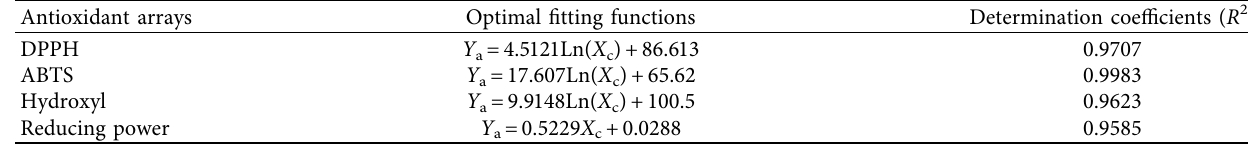
Table 6: The correlation between antioxidant activity and concentration of